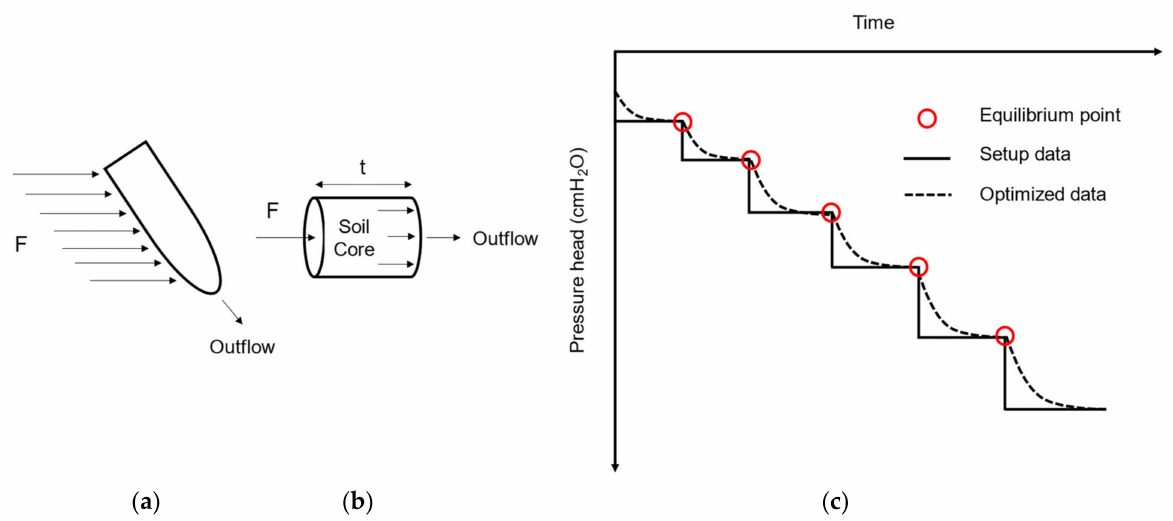
Figure 2. ( a ) Centrifuge power vector and drainage direction; ( b ) Traditional centrifuge outflow; ( c ) Descending pressure heads according to